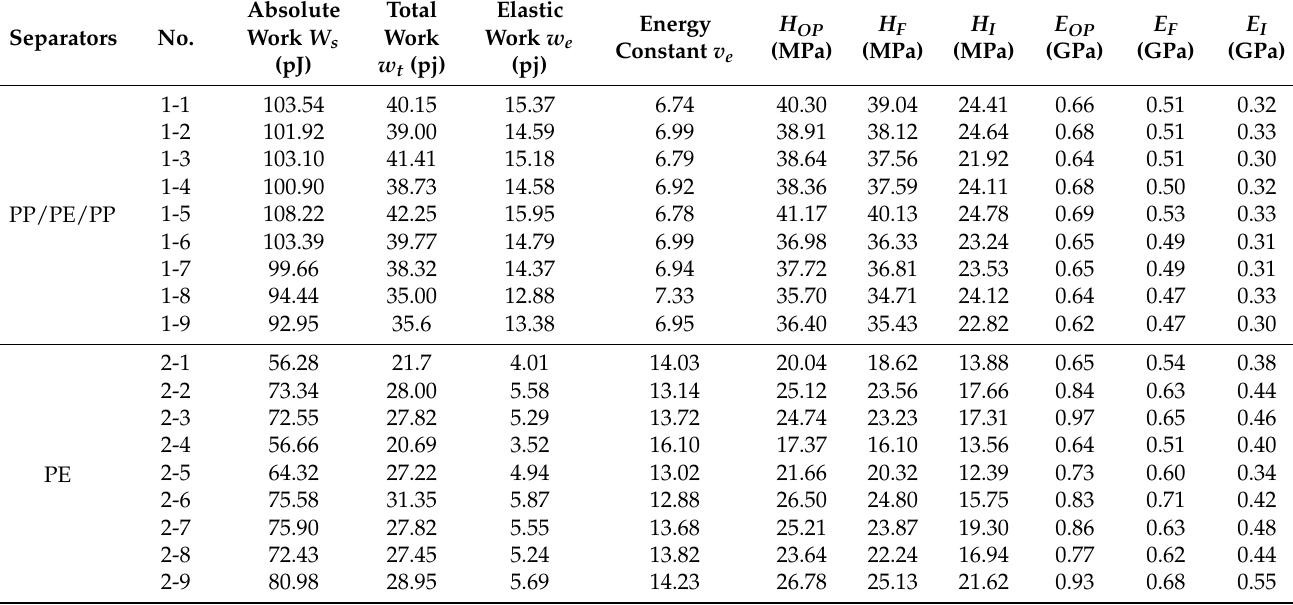
Table A2. Hardness and elastic modulus of specimens determined by Oliver–Pharr method, indenta- tion work method, and fitting curve method